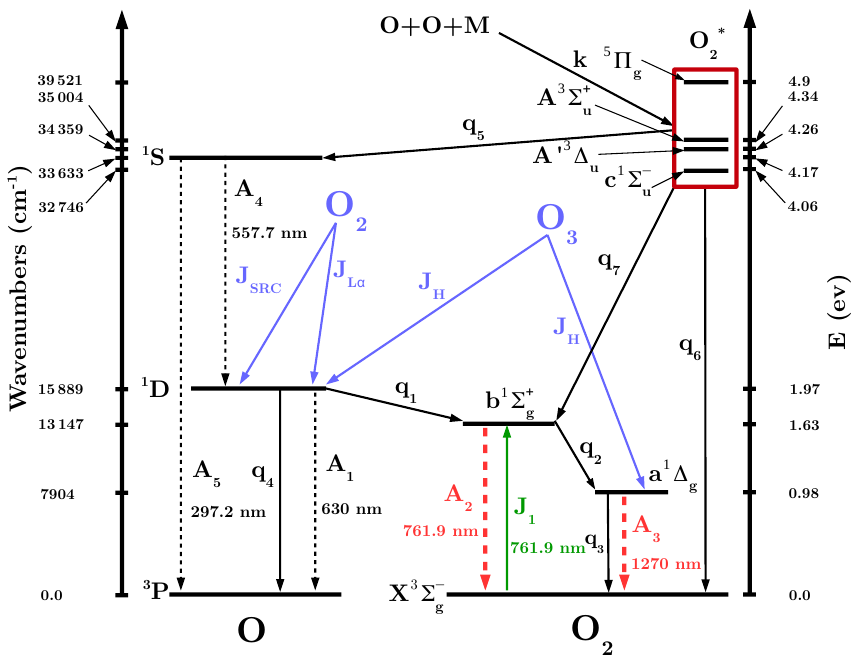
Figure 1. Schematic overview depicting processes that contribute to the production of Oxygen emission bands in the middle atmosphere. The black solid arrows are the most important gas phase reactions ( k ) and quenching reactions ( q i ). The blue and green solid arrows are photodissociation and photoexcitation processes respectively ( J i ). Dashed arrows correspond to spontaneous radiative emissions ( A i ), and the red dashed arrows show the radiative emissions that are the subject of this study. ( ∗ ) in O ∗